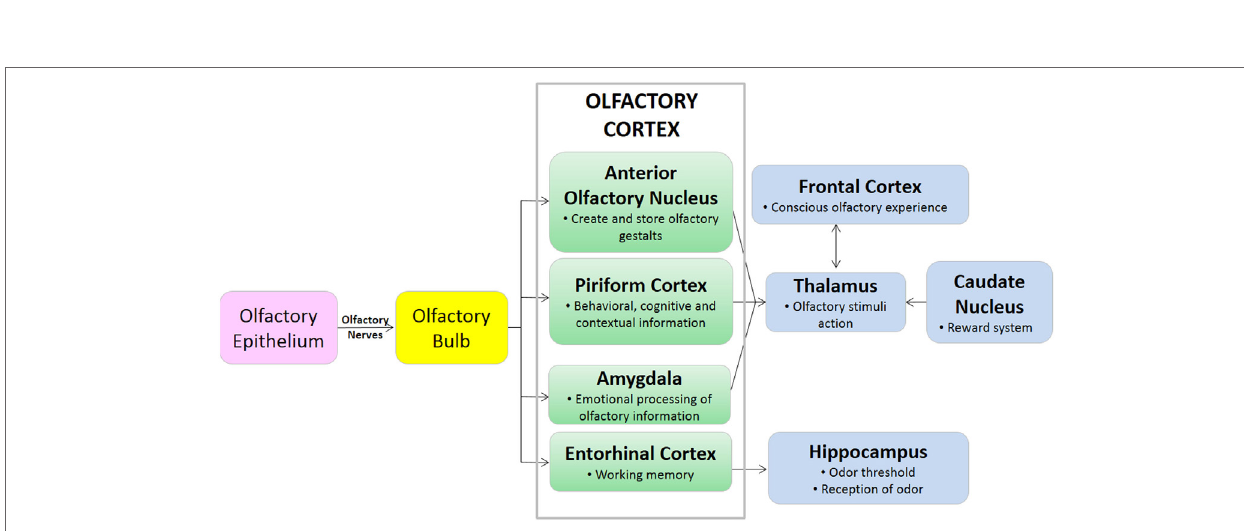
FigURe 1 | (A) Left sagittal plane highlighting the anatomy associated with olfaction. Photo credit: Adrien-Maxence Hespel, University of Tennessee. (B) Left exterior view demonstrating placement of interior structures associated with olfaction.